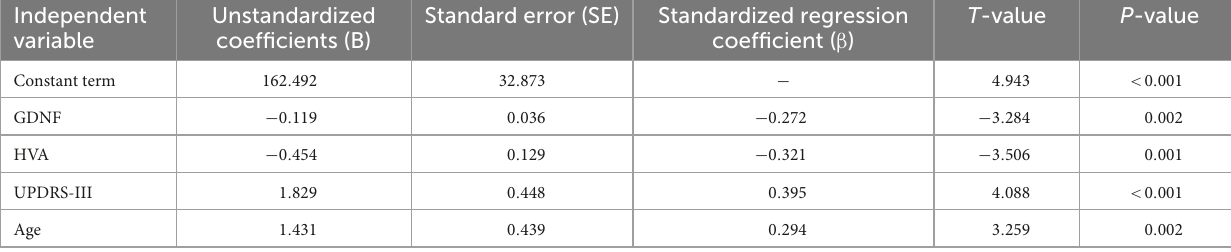
TABLE 5 Stepwise linear regression analysis results of TMT-B test as dependent